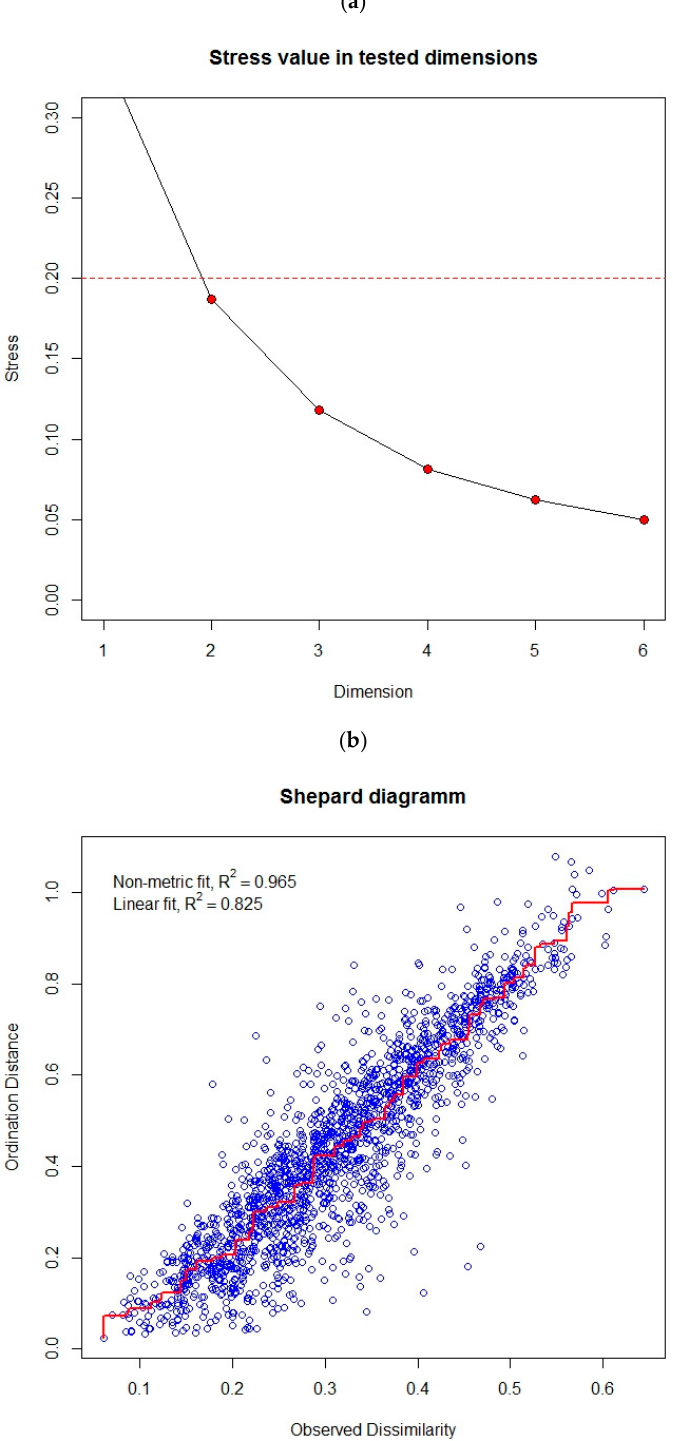
Figure A4. ( a ) Plot of stress indicating 2 (first point under the dotted line) as the best dimensionality for the ordination with non-metric multidimensional scaling (NMDS) and ( b ) Shepard diagram for the NMDS.